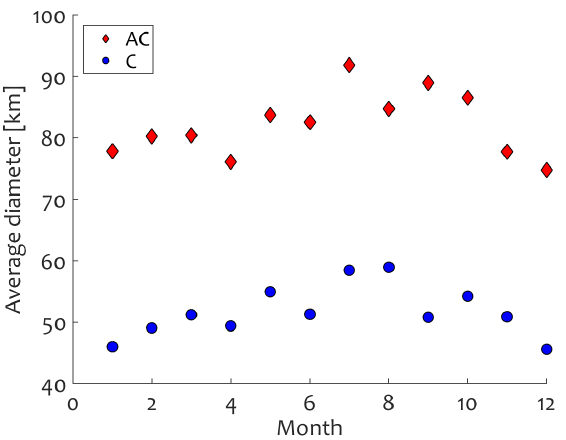
Figure 11. Monthly averaged eddy diameter for and eddies in the westernmost Western